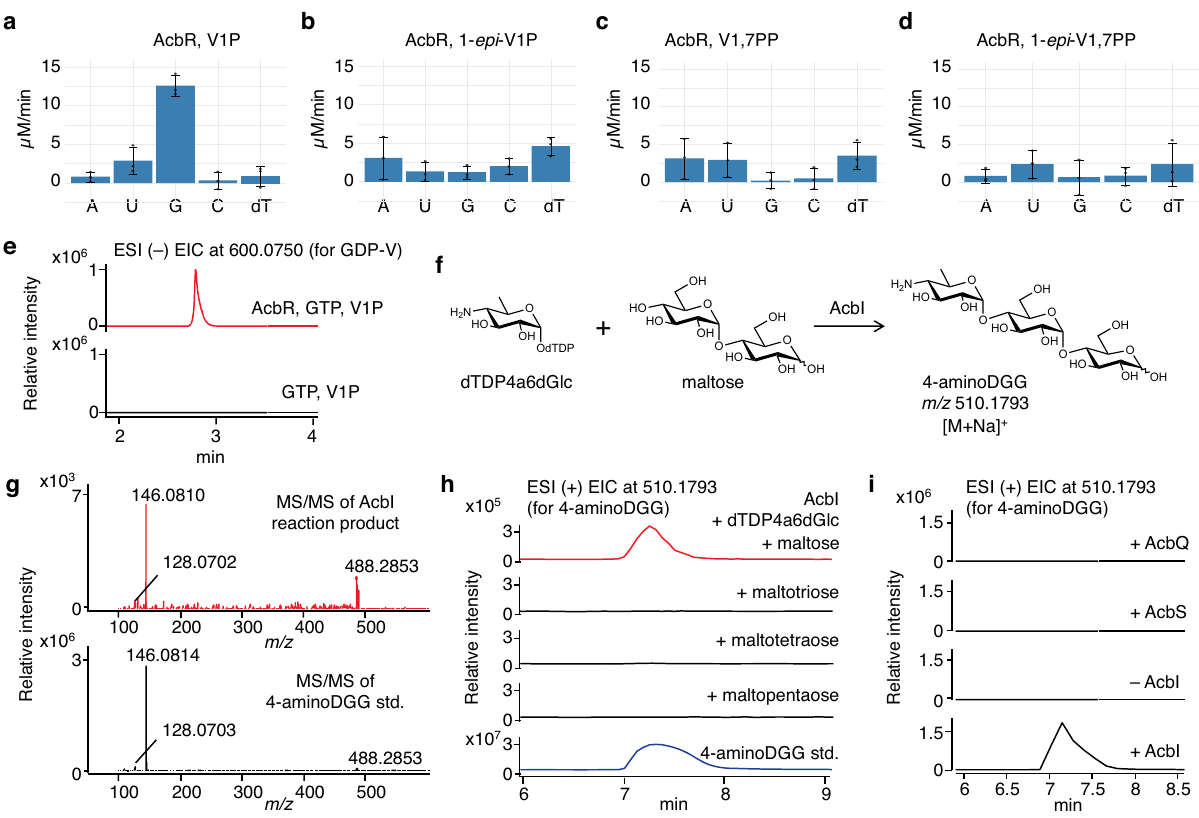
Fig. 3 Biochemical characterizations of AcbR and AcbI. a – d The activity of AcbR with V1P, 1- epi -V1P, V1,7PP, or 1- epi -V1,7PP as substrates incubated with various NTPs. The blank was a reaction mixture lacking AcbR. A: ATP, U: UTP, G: GTP, C: CTP, dT: dTTP; e Partial LC-QTOF/MS EIC chromatograms (negative ion mode) of AcbR reaction with V1P and GTP (in red) and the negative control lacking AcbR (in black). Both chromatograms are the extraction of corresponding calculated exact mass for GDP-valienol ( m/z 600.0750 [M-H] – ). f Coupling between dTDP4a6dGlc and maltose catalyzed by AcbI; g MS/MS analysis of the product of the AcbI reaction; h ESI( + ) EIC for 4-aminoDGG ( m/z 510.1793, [M + Na] + ) from AcbI reactions with maltose, maltotriose, maltotetraose, and maltopentaose; and ( i ) ESI( + ) EIC for 4-aminoDGG ( m/z 510.1793 [M + Na] + ) from AcbQ, AcbS, and AcbI reactions with maltose. For a – d , error bars indicate standard deviation (SD) (n = 3 analytical replicates), and data are presented as mean values ± SD. All experiments were carried out at least three times with similar results. ESI, electrospray ionization mass spectrometry; EIC, extracted ion chromatogram; V1P, valienol 1-phosphate; V1,7PP, valienol 1,7-diphosphate; 1- epi -V1,7PP, 1- epi -valienol 1,7-diphosphate; A, ATP; U, UTP; G, GTP; C, CTP; dT, dTTP;